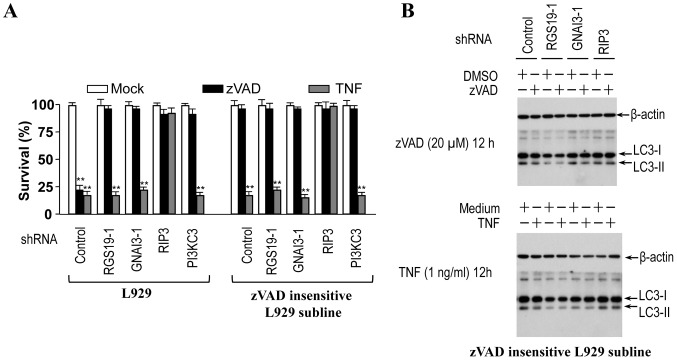
RGS19-, GNAI3- and RIP3-dependent autophagy is required for zVAD-induced but not TNF-induced cell death.(A) Knockdown of RGS19, GNAI3 or PI3KC3 had no effect on TNF-induced cell death in zVAD insensitive L929 subline. Control and RGS19- or GNAI3-knockdown L929 cells (left panel) and zVAD insensitive L929 cells (right panel) were treated for 24 h with mock, TNF (10 ng/ml) or zVAD (20 µM). Then cell viabilities were measured. (B) zVAD insensitive L929 subline had defect in RGS19-, GNAI3- and RIP3-dependent zVAD- or TNF-induced modification of LC3. Control and RGS19-, GNAI3- or RIP3-knockdown zVAD insensitive L929 cells were treated with mock, TNF (1 ng/ml) or zVAD (20 µM) for 12 h. Cell lysates were subjected to western blot analysis with antibodies against LC3 and β-actin. **, p<0.01.